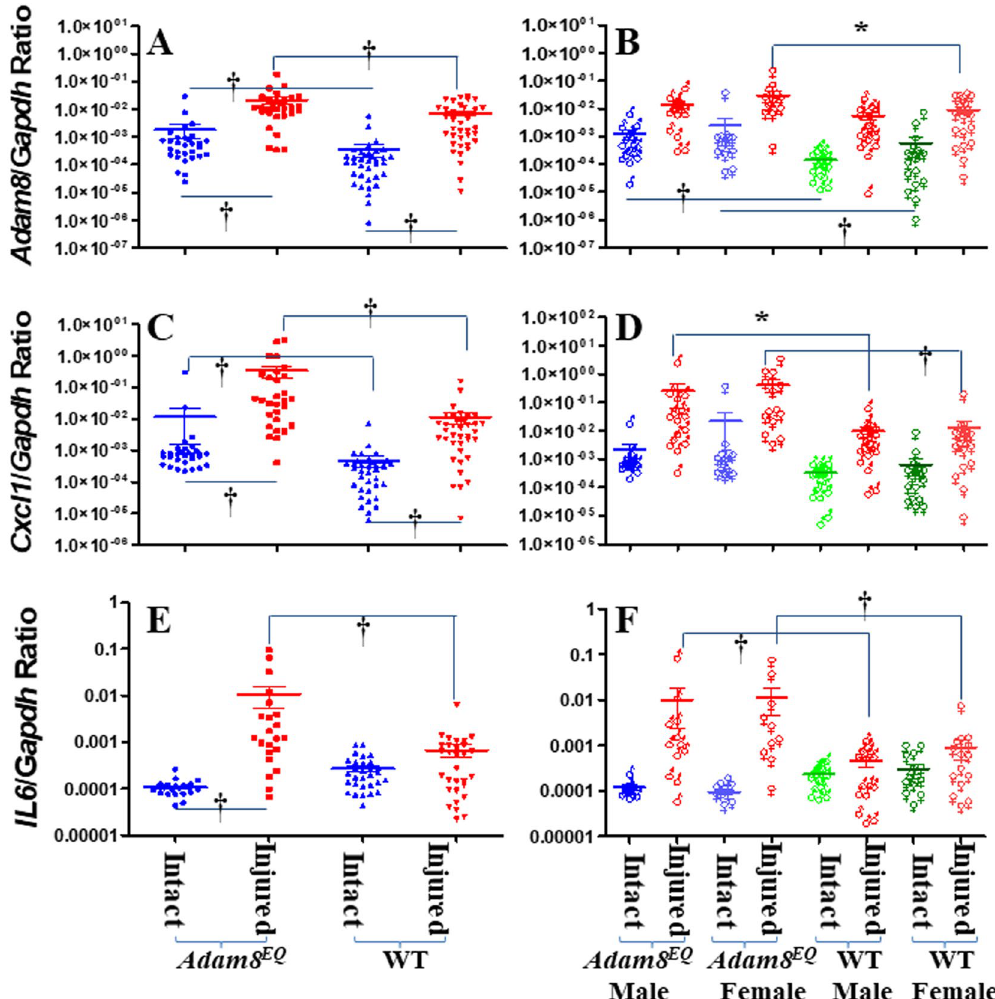
Figure 2. Adam8 and Pro-inflammatory Gene Expression in the Injured Mouse Tail Intervertebral Disc. ( A , B ) Adam8 gene expression; ( C , D ) Cxcl1 gene expression; ( E , F ) IL6 gene expression. WT wild type. Each point shows data from one intervertebral disc from an individual mouse. † p ≤ 0.01; *p ≤